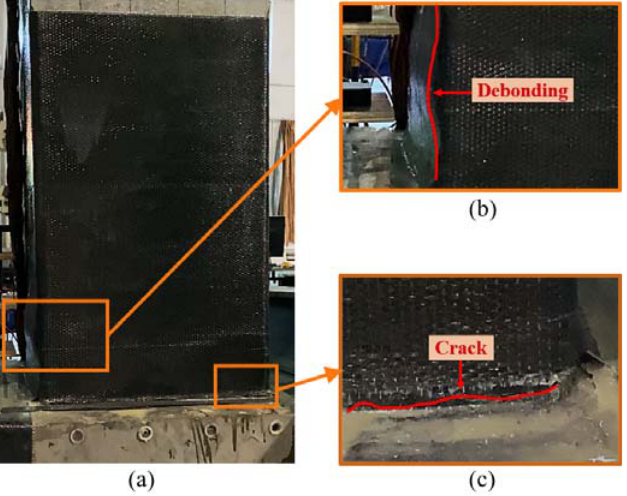
Figure 9. Damage at the displacement level of 70 mm for the repaired specimen: ( a ) damage for the repaired specimen; ( b ) debonding of the CFRP fabrics; ( c ) crack at the column–footing interface.